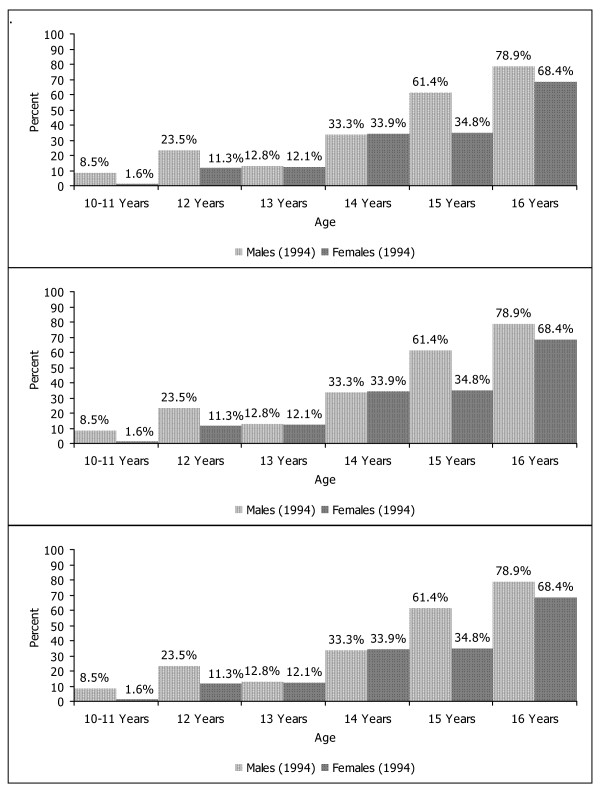
Frequencies of alcohol consumption (≥1 glass of alcohol ever) at three times.